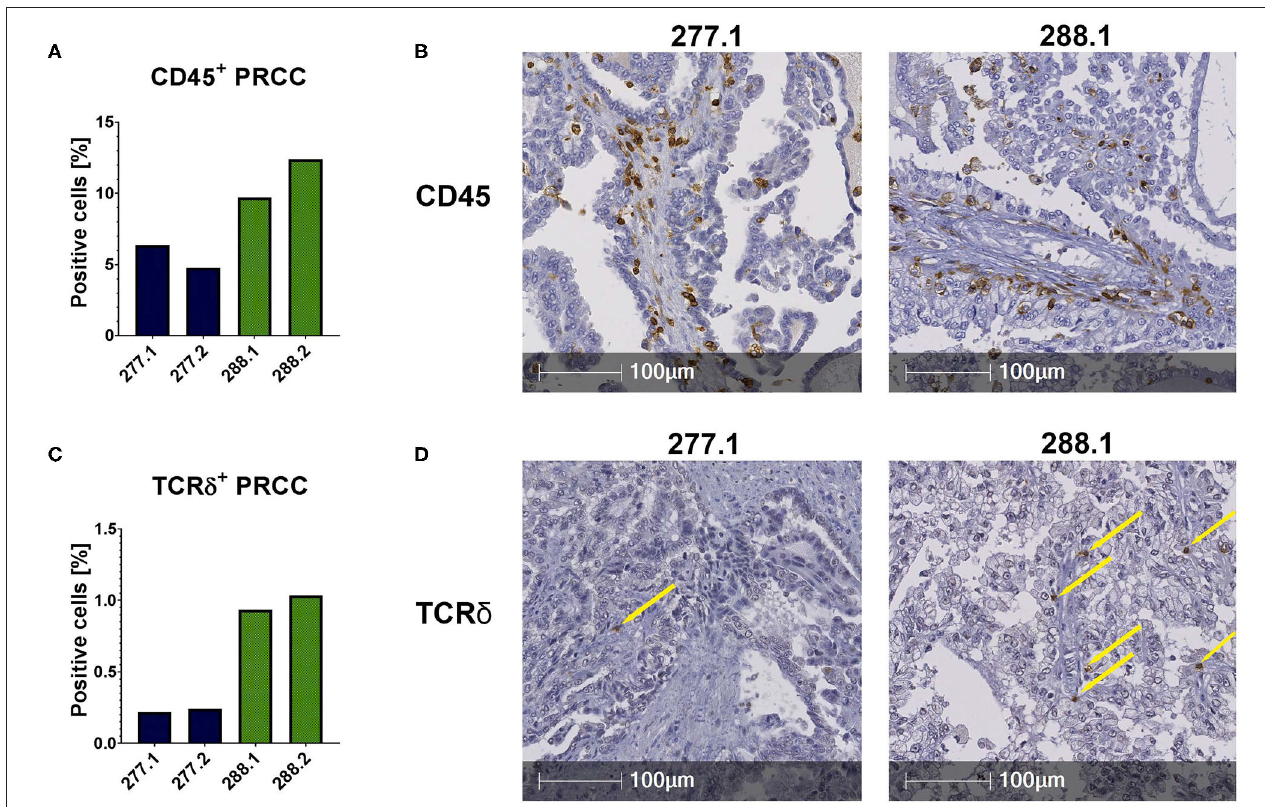
FIGURE 2 | IHC stainings of PRCC tumor samples. IHC stainings were performed using specific antibodies against CD45 and TCR δ . Staining with DAB identified positive cells, nuclear counterstaining was performed using hematoxylin. Of each case two different sections were stained and analyzed (277.1, 277.2, 288.1, and 288.2). Tumor area was defined and positive cells within this area were quantified using HALO software. (A) Quantitative analysis of CD45 + labeled cells. Both samples are infiltrated by CD45 + cells. Sample 288 displays a higher amount of CD45 + cells than 277. (B) Anti-CD45 IHC stainings (samples 277.1 and 288.2).